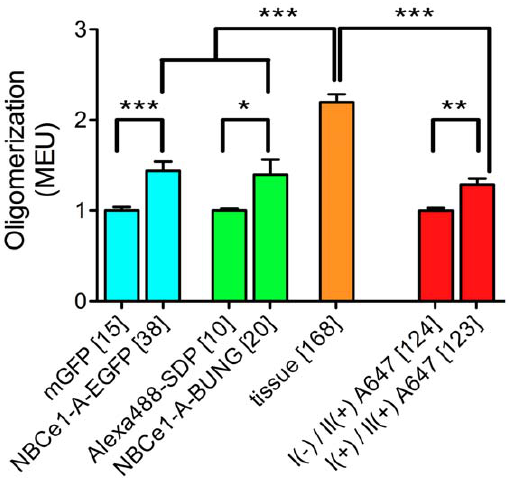
Figure 6. Spatial fluorescence intensity moment analysis of NBCe1-A oligomerization state in expression systems and native tissues. The cotransporter is predominantly a monomer when it is expressed heterologously in CHO-K1 cells, and is a dimer or rarely higher order oligomer in rat kidney tissue. The error bars represent the standard error of the means obtained from multiple cells. Numbers in square brackets represent n cells. Nonparametric t -tests were per- formed on the selected data sets (*** = p , 0.001, ** = p , 0.01, *=p , 0.05). All of the measurements were carried out under identical collection